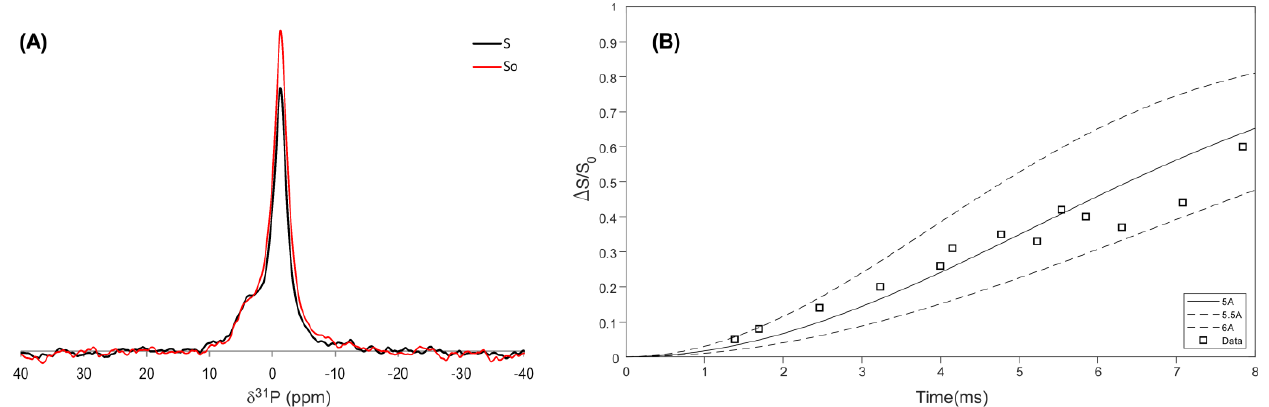
Figure 4. REDOR analysis of gVp-ssDNA complex. ( A ) 31 P S (black) and S 0 (red) REDOR signals of gVp-ssDNA complex that were obtained at a mixing time of 3.23 ms. ( B ) 31 P{ 13 C} REDOR fraction curve and SIMPSON simulations showing the best fit at 5.5 ± 0.5 Å. Simulations were obtained for a four-spin system consisting of one phosphorous spin and three carbon spins. 31 P shifts are referenced relative to O-phospho-L-Serine at 0.3 ppm.